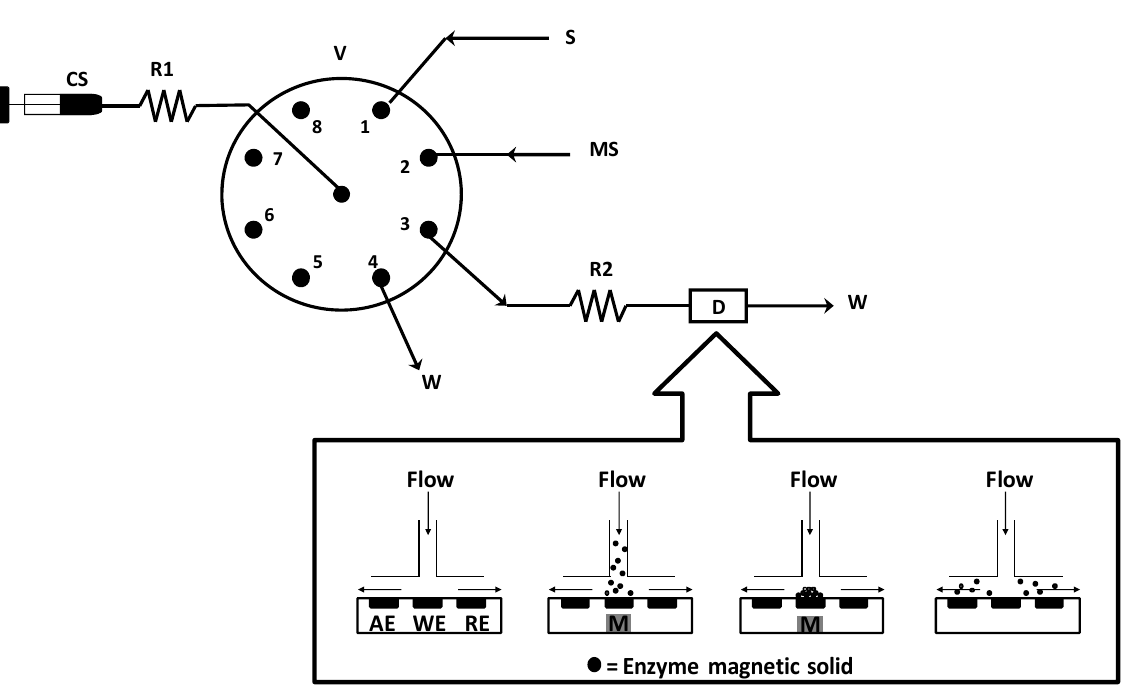
Figure 6. Diagram of the SIA system used to determine oxalate. Sy, syringe; CS, carrier solution; R1, loading reactor; V, selection valve; S, sample; MS, enzyme magnetic suspension; R2, reaction coil; D, detector; W, waste; AE, auxiliary electrode, WE, working electrode; RE, reference electrode; M,